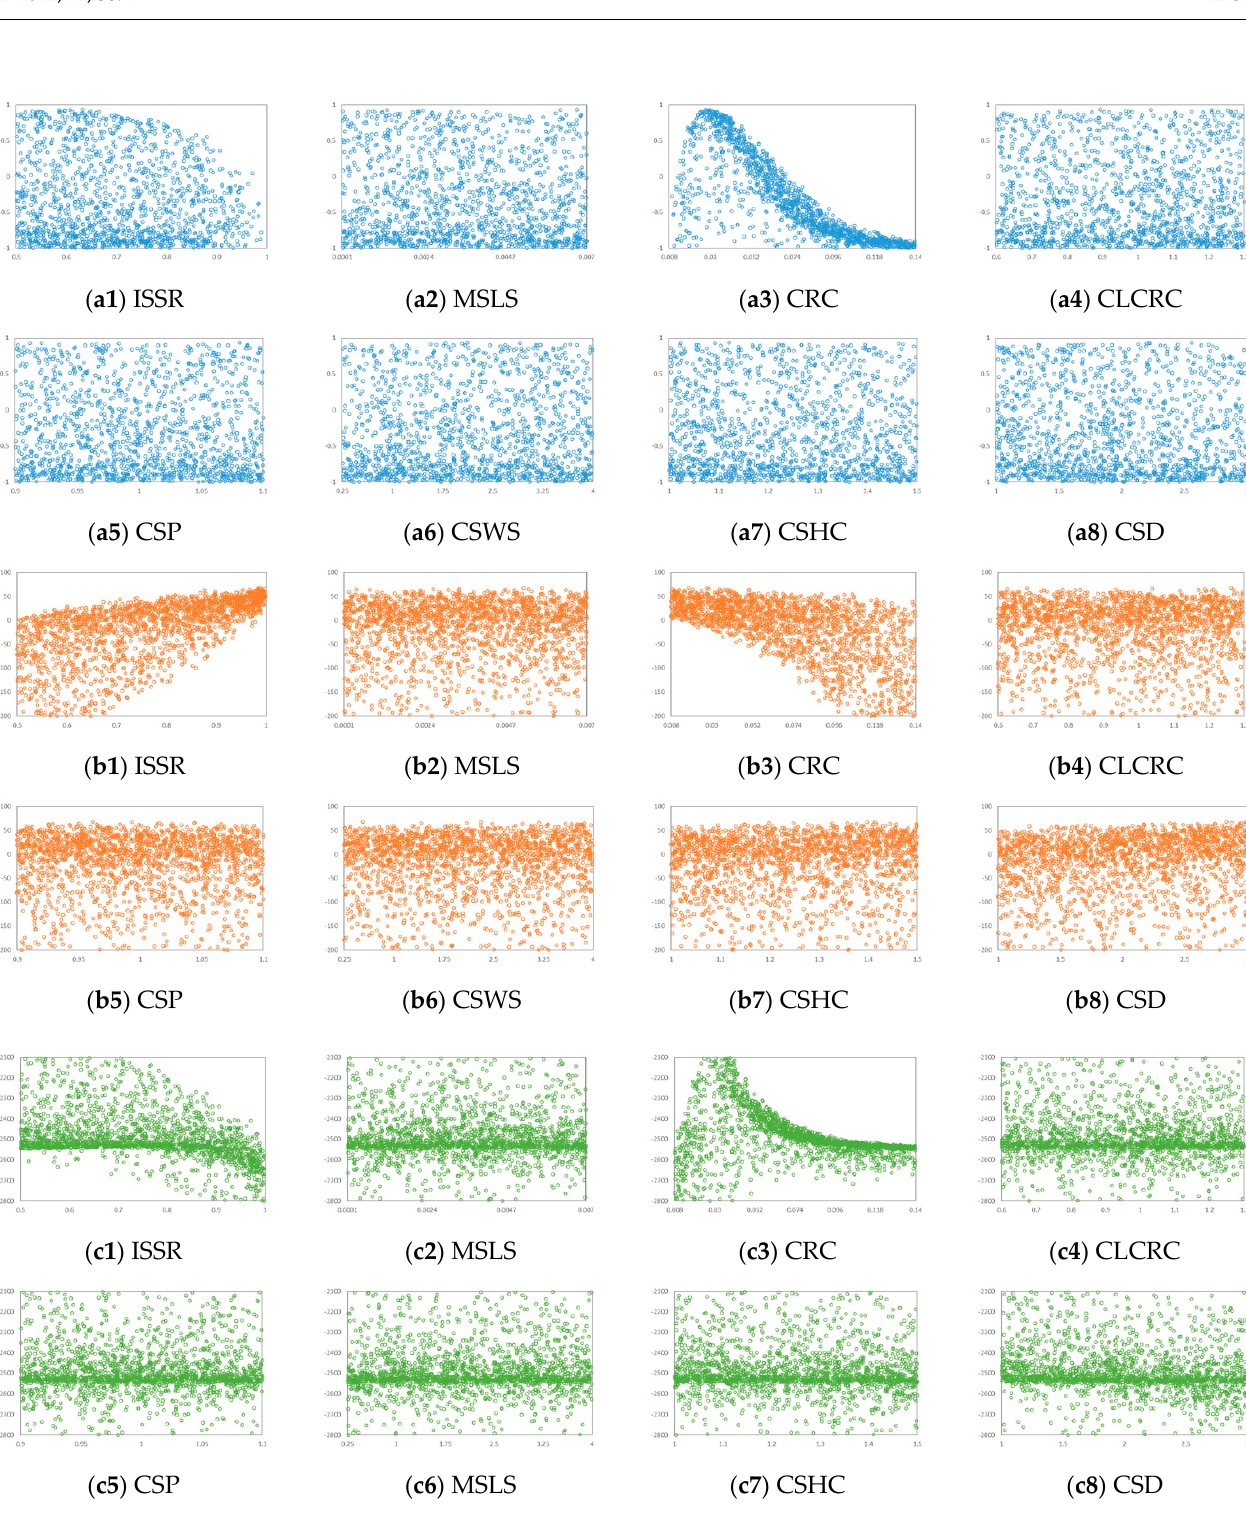
Figure 8. Distribution of L3 − based behavioral models by parameter ( a1 – a8 ) NSE results; ( b1 – b8 ) PBIAS results; ( c1 – c8 ) LOG results.